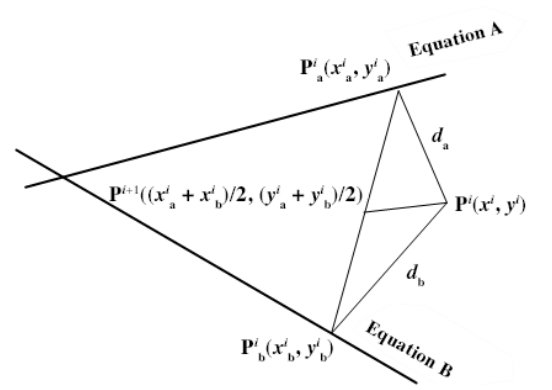
Fig. 2. Determination of the next iterate direction in the iterative system